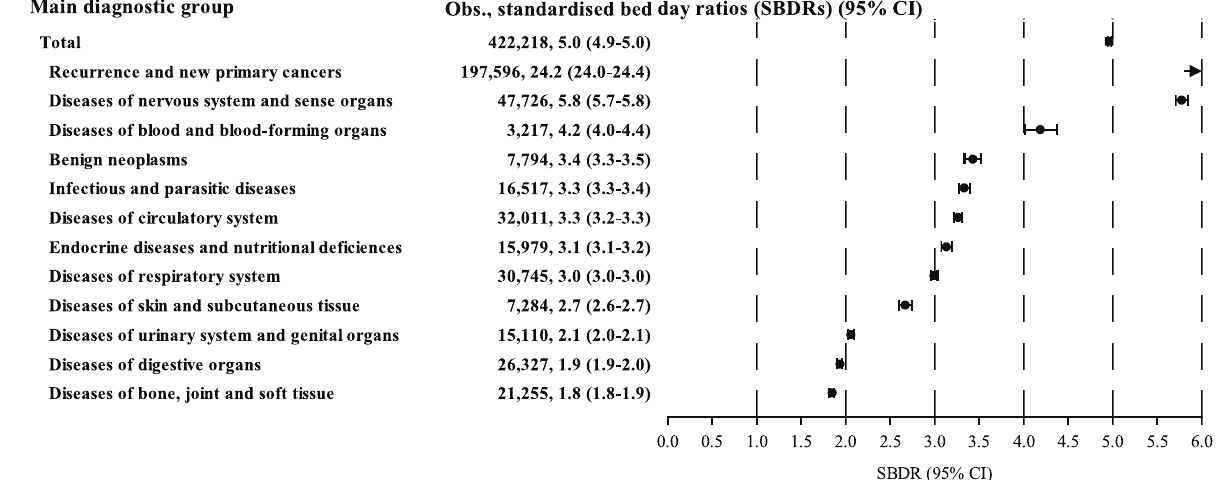
Fig 5. Number of bed days at hospital and associated standardised bed day ratios (SBDRs) for diseasesin each of the 12 main diagnostic groups. Note that the diagnosticgroup “Recurrence and new primary cancers” is beyondthe scale, with a standardised hospitalisation rate ratio (RR) of 24.2. 95% CI, 95% confidenceinterval; Obs., observed.